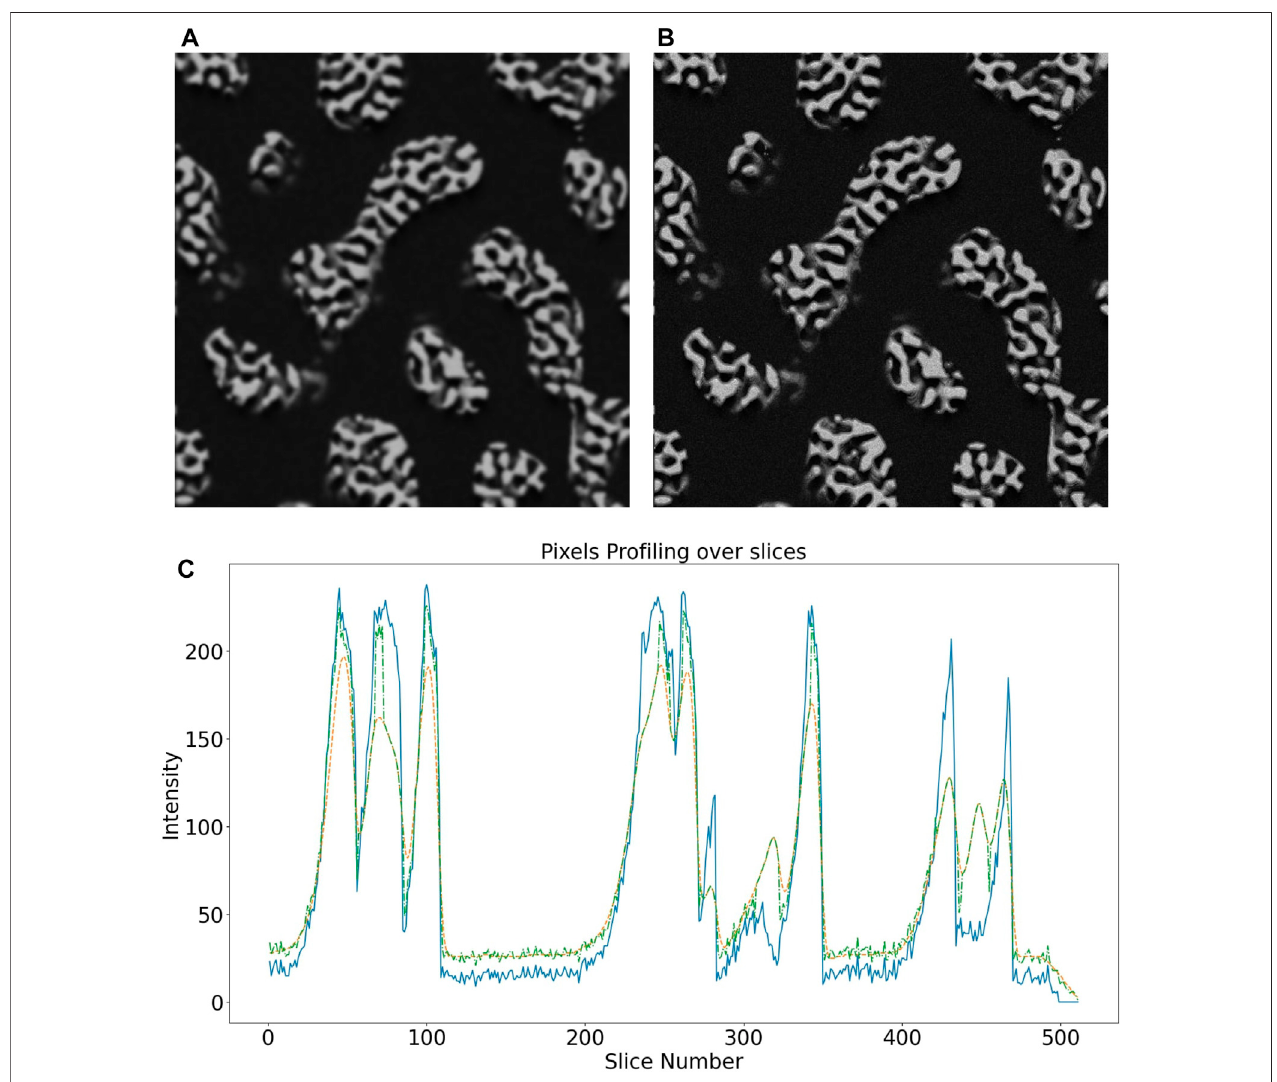
FIGURE 4 | Synthetic SEM image after applying (A) standard Gaussian blur fi lter and (B) the 4-step blurring procedure introduced herein (C) intensities of pixel located at a random location in the xy-plane across slices before blurring (blue), after applying Gaussian blur fi lter (orange) and 4-step blurring procedure (green).